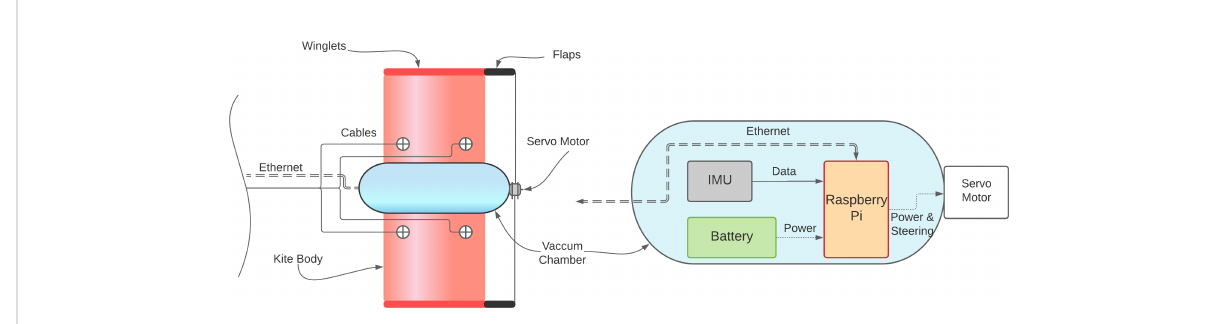
FIGURE 2 Schematic setup of fi rst prototype with the overall design on the left and a more detailed look inside the acrylic vacuum chamber on the